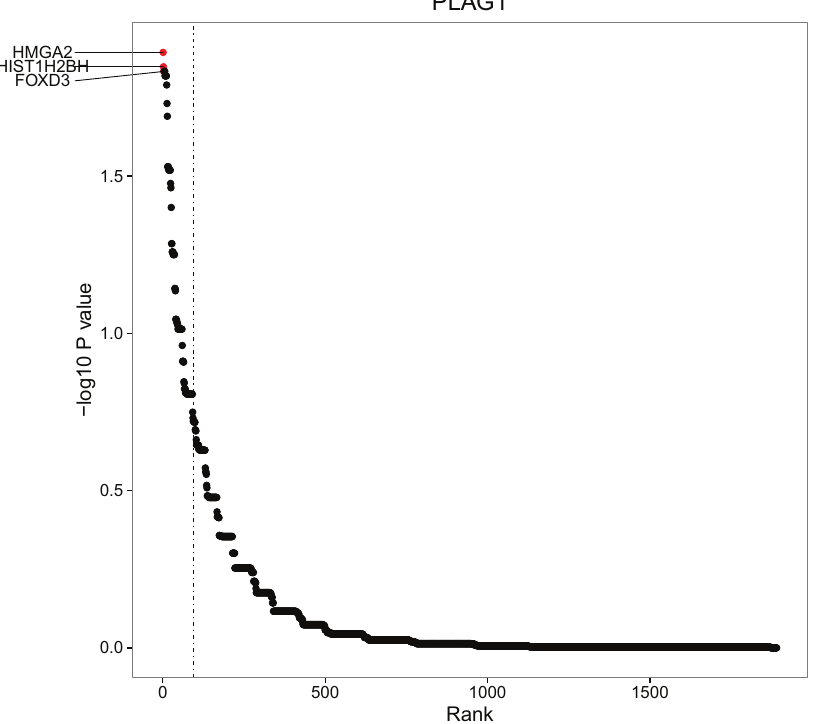
Figure 18. TF ranking plots based on the score ( –log ( Pvalue )) of association between TF expression and DNA methylation of the FOX motif. The dashed line indicates the boundary of the top 5% association scores and the TFs within this boundary were considered candidate upstream regulators. The top three associated TFs and the TF family members (dots in red) that are associated with that specific motif are labeled in the plot.